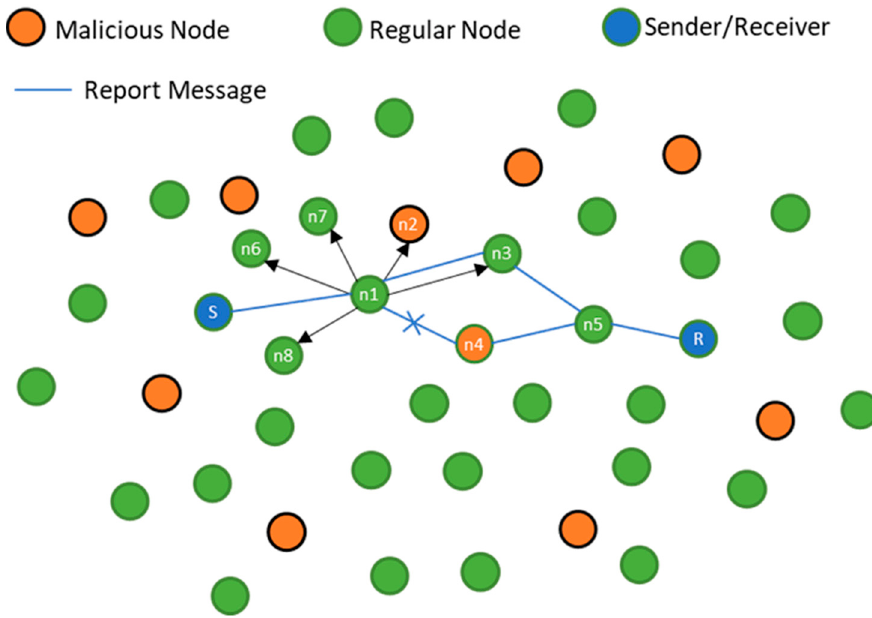
Figure 3. A Scenario with 32 nodes with 10 malicious nodes.